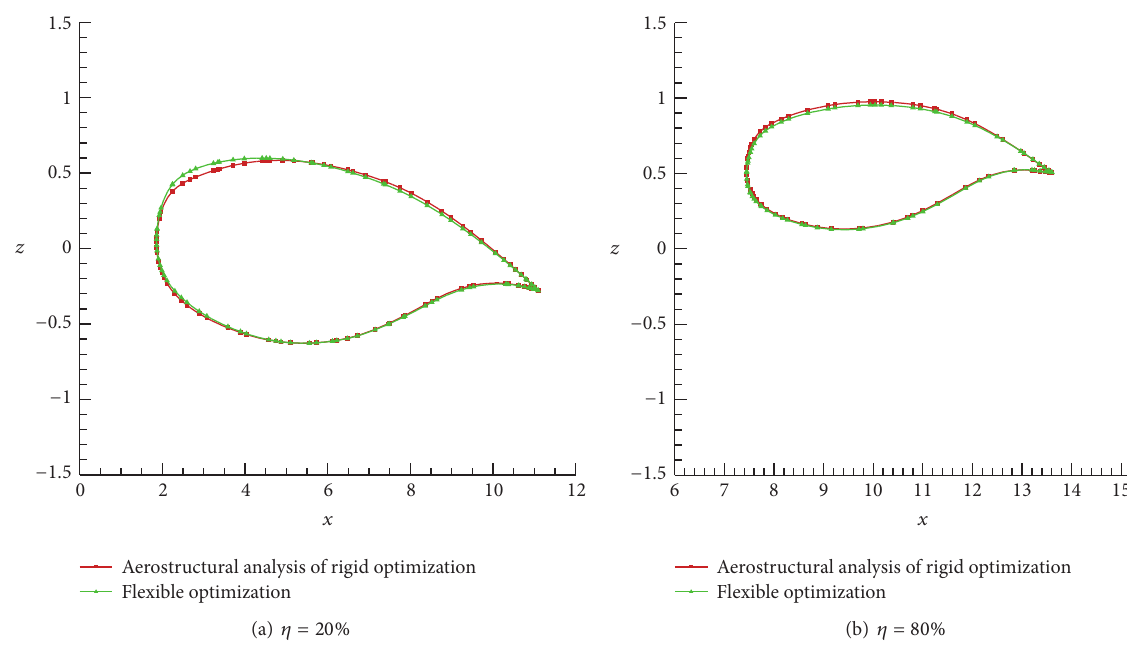
Figure 19: Comparison of section shapes of aerostructural analysis of rigid optimization and flexible